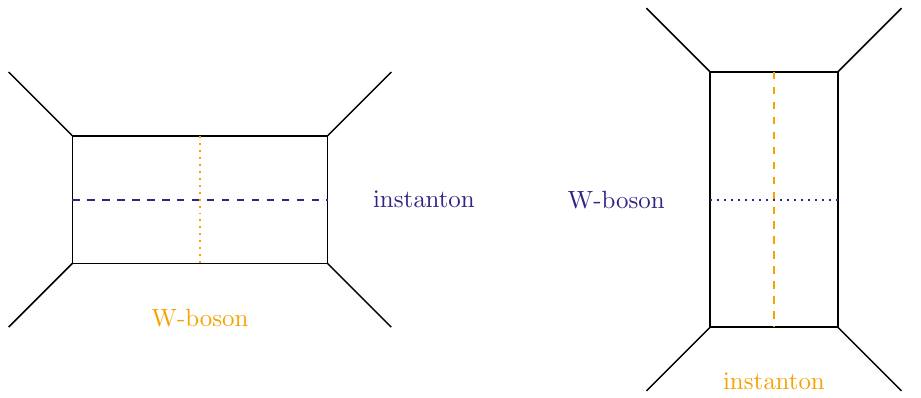
Figure 1 . Brane con(cid:12)gurations corresponding to the pure SU(2) gauge theory on the Coulomb branch. Horizontal lines represent D5-branes and vertical lines NS5-branes. A fundamental string stretched between D5-branes corresponds to a W-boson in the (cid:12)eld theory on the left-diagram, \ while it appears as an instanton of the dual SU(2) gauge theory on the right. The supersymmetric CFT arises when the rectangle shrinks to a